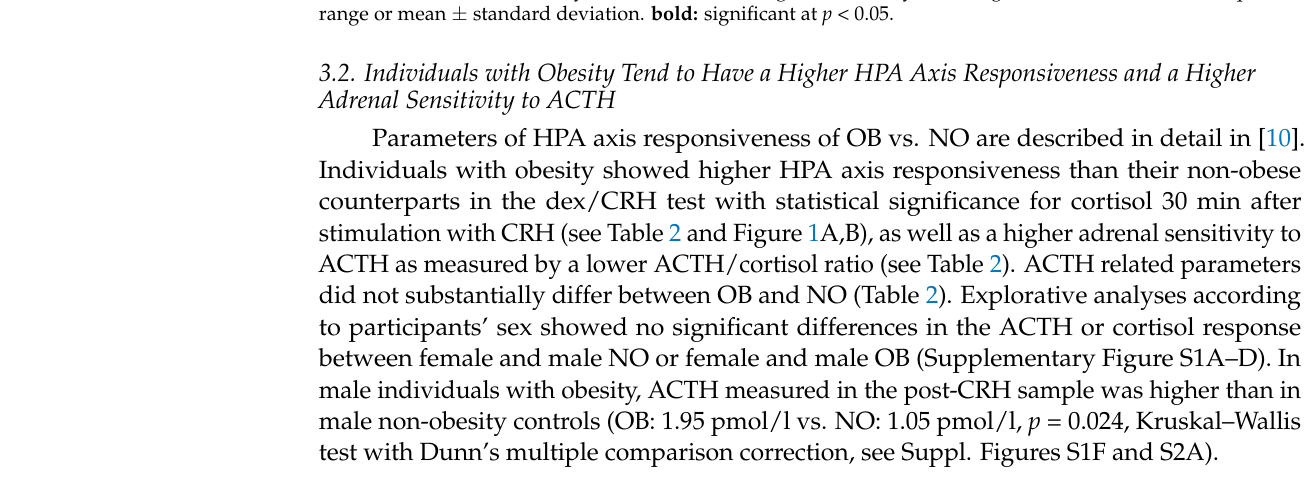
Table 2. Dex/CRH test indicators in the obesity group and non-obesity